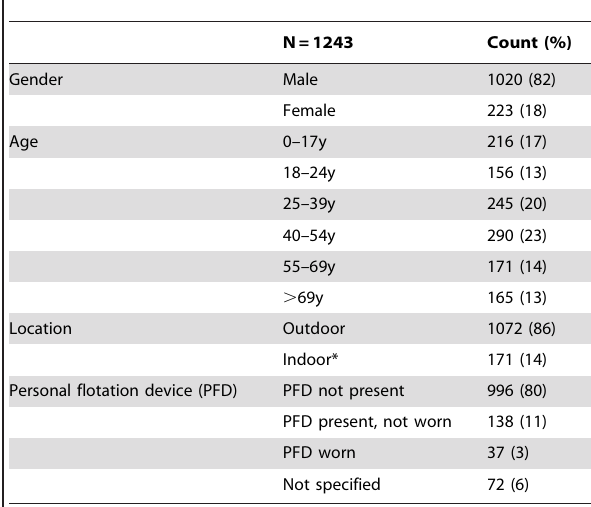
Table 1. Drowning Characteristics.